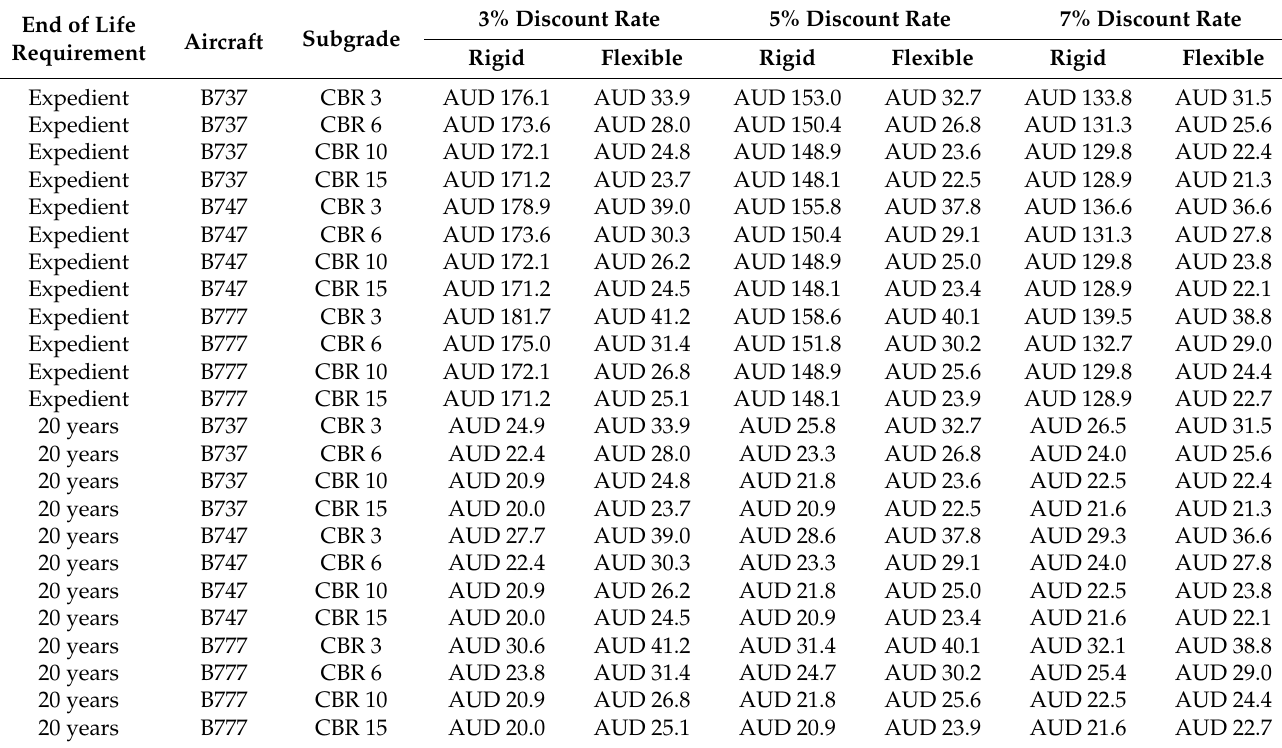
Table A2. Forty-year Whole of Life Costs (millions) for alternate rigid end of life